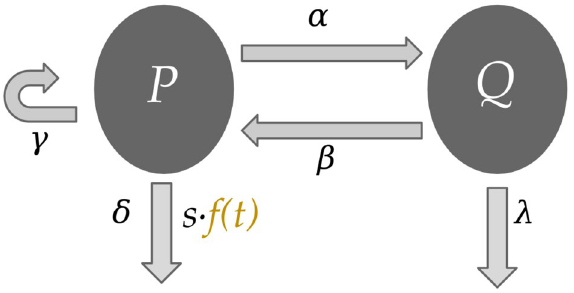
Figure 2. The two-compartment tumour growth inhibition model described by Eq. (1). Proliferative ( P ) cells and quiescent ( Q ) cells can both die naturally at the constant rates δ and (cid:31) , respectively. However, only proliferative cells can self-renew (at the constant rate γ ) and be killed by the dose of a chemotherapeutic f ( t ). Moreover, proliferative cells are allowed to become quiescent (at constant rate α ) and quiescent cells are allowed to become proliferative (at constant rate β